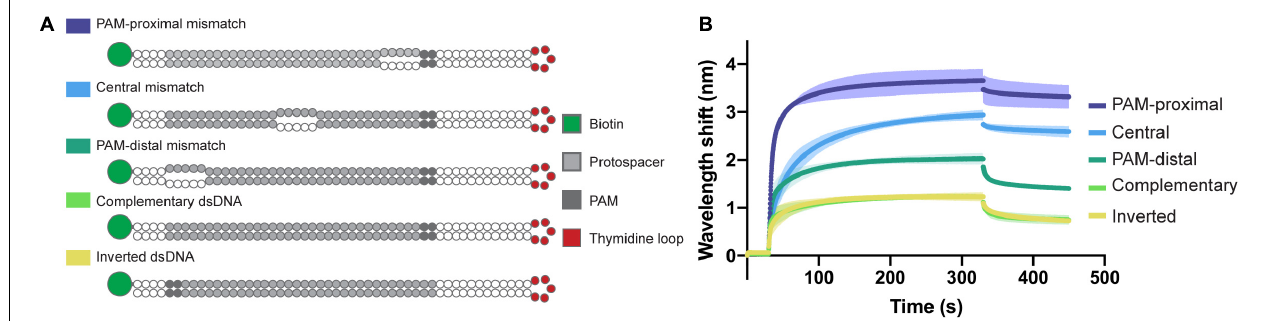
FIGURE 5 | Influence of dsDNA mismatches on Type I-Fv Cascade binding. (A) Schematic structures of dsDNA oligonucleotides used in the binding assay. Targets are either fully hybridized or contain 5 nt mismatches at positions in the protospacer close to the PAM, in the centre or at the PAM-distal end. (B) Wavelength shift (nm) generated by the addition of 1.5 µ M Type I-Fv Cascade from S. putrefaciens CN-32 to the indicated dsDNA oligonucleotides. Assays were performed in duplicate. The lighter outlines represent the